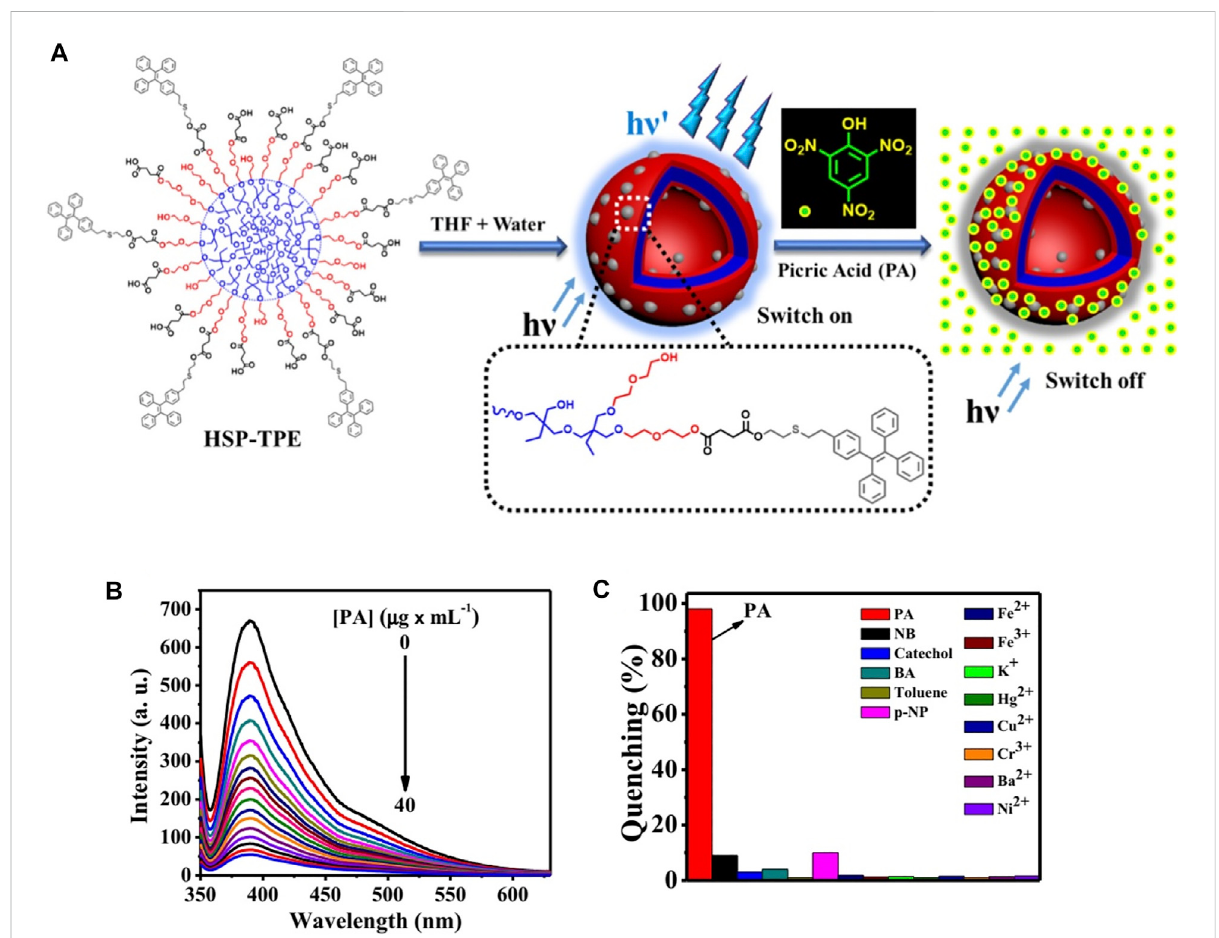
FIGURE 11 (A) Illustration of self-assembly of the copolymer (HSP-TPE) containing fl uorescent TPE probe and sensing behavior of HSP-TPE aggregates toward picric acid (PA); (B) fl uorescent spectra of (A) HSP-TPE in THF/water (3:7 v/v) mixture with varied amount of picric acid (PA) at an